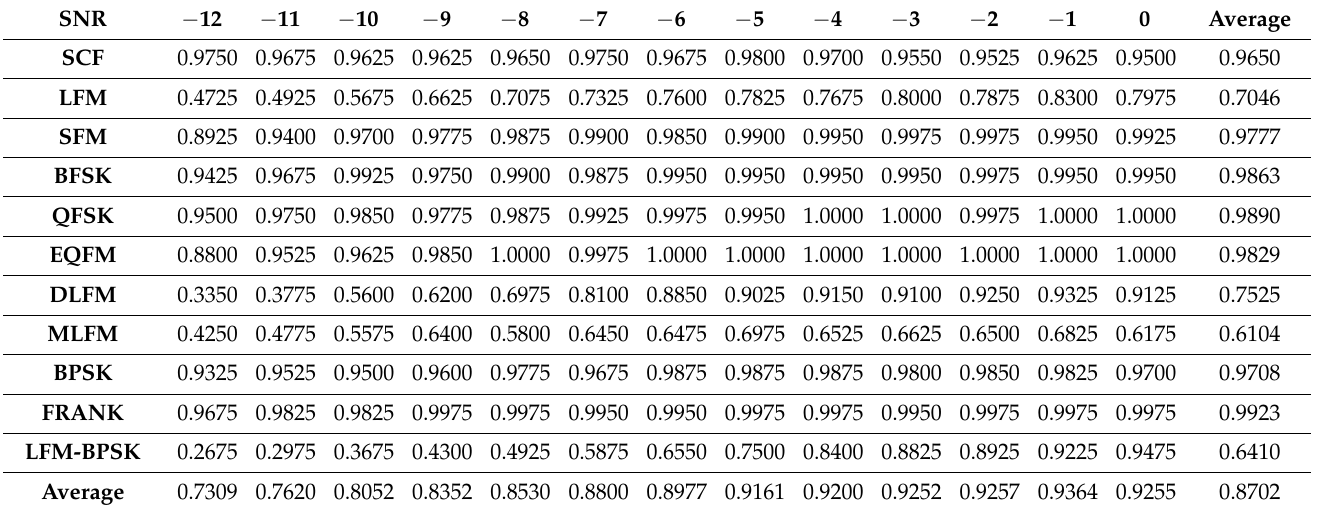
Table A6. Semi-supervised classification results with the datasets in Situation Dataset 4 ( T cycle = 26, NUM = 2145).